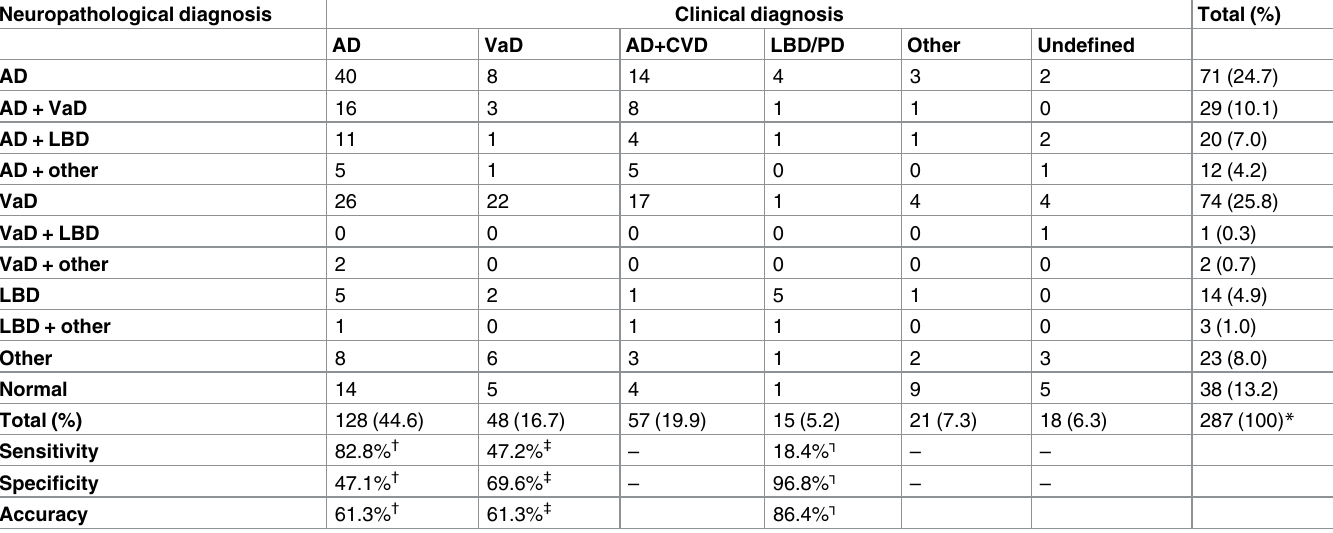
Table 4. Comparison between clinical and neuropathological diagnoses among participants with dementia (CDR (cid:21) 1) ( n = 287). Neuropathological